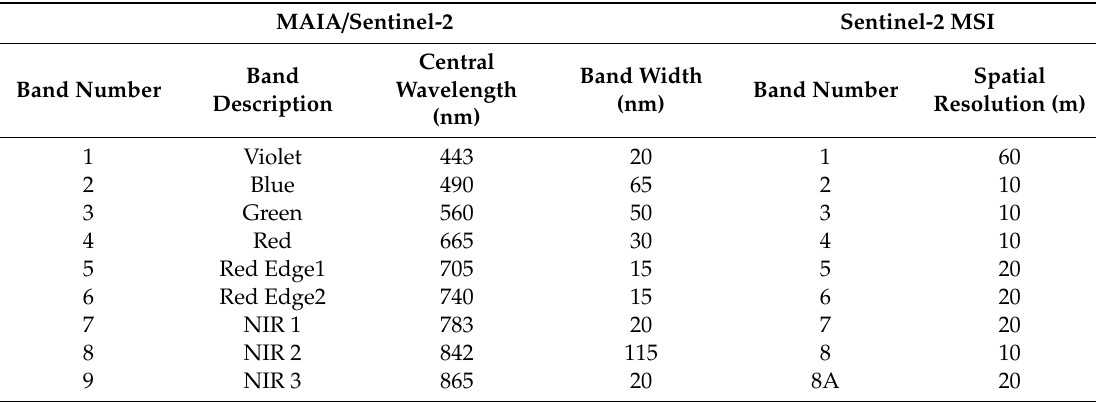
Table 2. Description of the MAIA / Sentinel-2 UAV multispectral camera bands and the corresponding Sentinel-2 multispectral instrument (MSI) bands, including the near-infrared (NIR) bands, and spatial resolution. Note: Band 1 (violet) was not used in the MAIA / Sentinel-2 band analysis. MAIA /